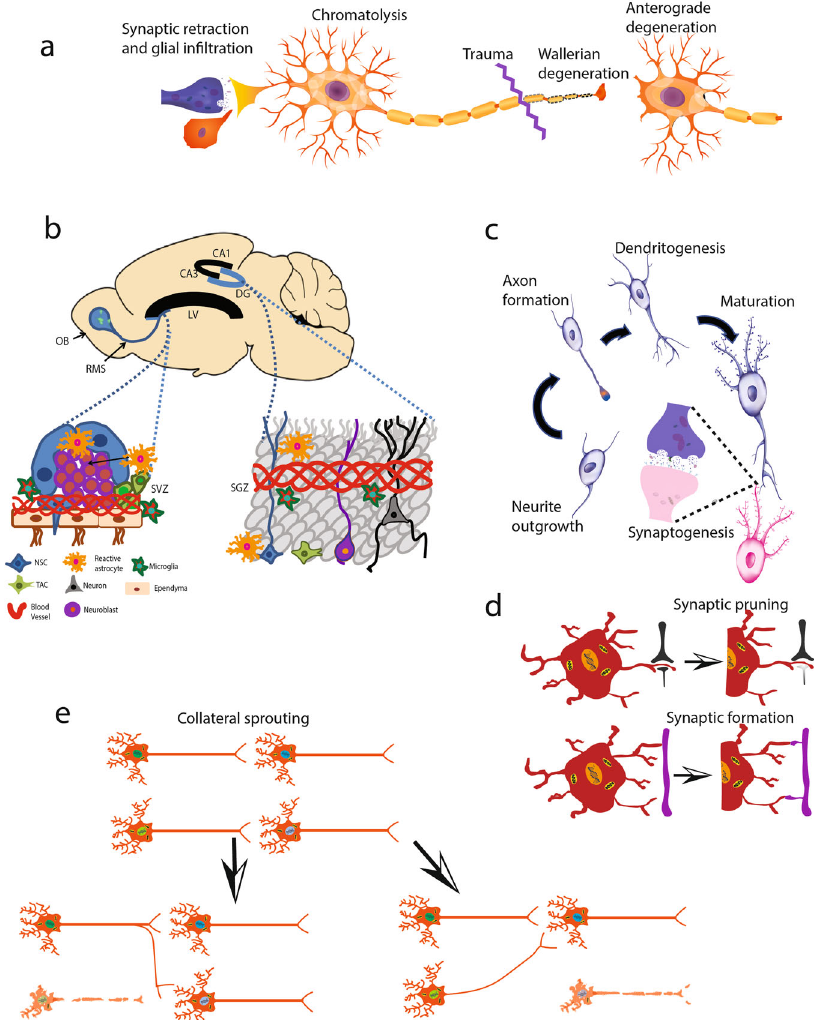
Fig. 1 Damage and Repair at the Cellular Level in the Central Nervous System. A Traumatic injury through shearing or crushing action leads to Wallerian degeneration distal to the site of injury and accompanying demyelination; retrograde degeneration leads to chromatolysis with swelling of the cell body, nuclear displacement, fragmentation of the rough endoplasmic reticulum and metabolic changes. Synapses withdraw, and glial in fi ltration and proliferation ensue. These effects on synapses can affect neurons in circuits either upstream or downstream from the injured cell. B Neurogenesis is enhanced by injury in animal model systems in the subventricular zone and in the hippocampus. The extent to which neurogenesis occurs in the adult human is unclear, though it is known in model systems that quiescent neural stem cells can undergo activation in the adult. Glia and endothelial cells can modulate neurogenesis. C Connectivity may be restored by outgrowth of neurites, axon formation, dendritogenesis, and synaptogenesis. In the CNS, these processes may be limited by a non-permissive